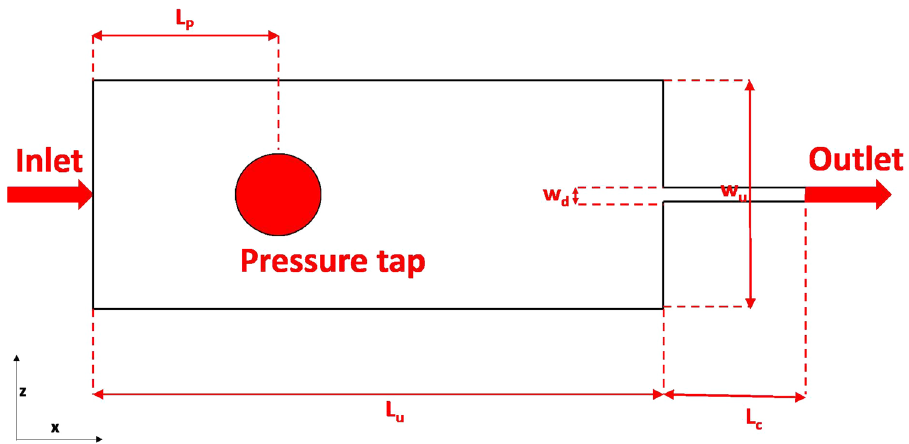
Fig. 2 Schematic diagram of the “syringe-on-chip” microflu- idic geometry. The dimensions